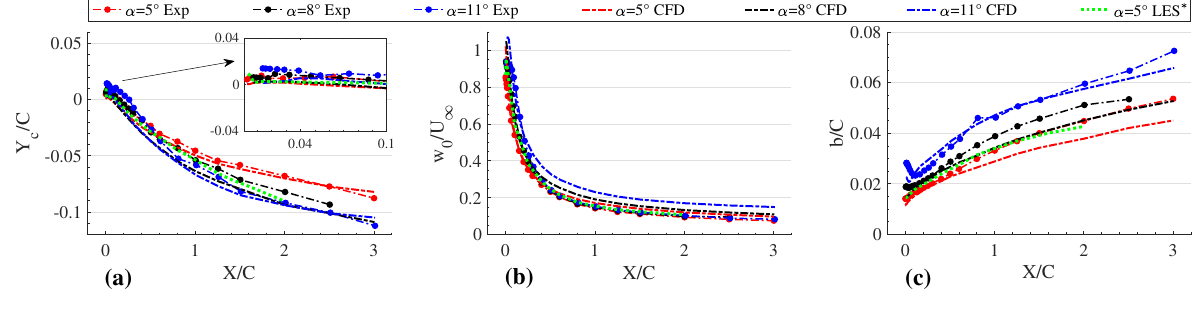
Figure 16. ( a ) Normal position ( Y ) of the wake centre at different AOAs for EXP and CFD data, scaled with the chord length C . ( b ) Maximum wake deficit for different AOAs according to CFD and EXP. ( c ) Averaged half-width b for different AOAs according to CFD and